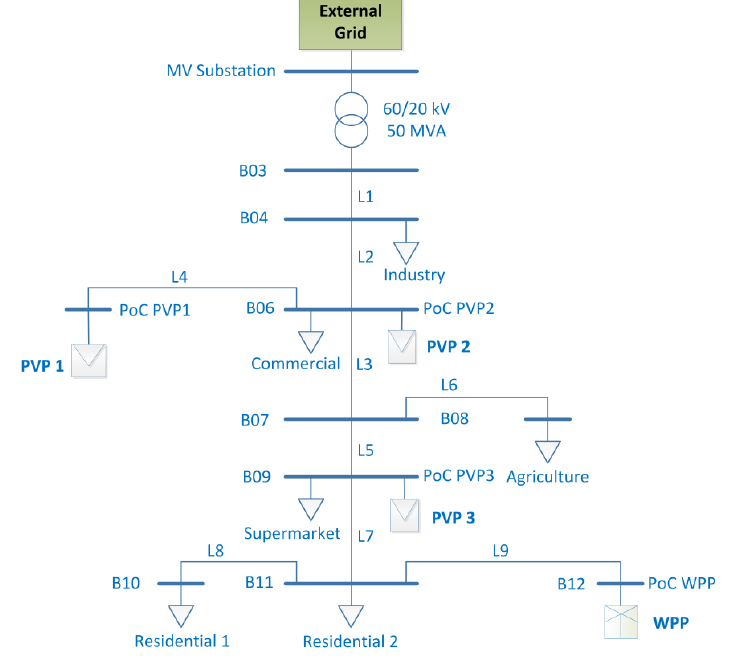
Figure 4. Structure of the MV benchmark